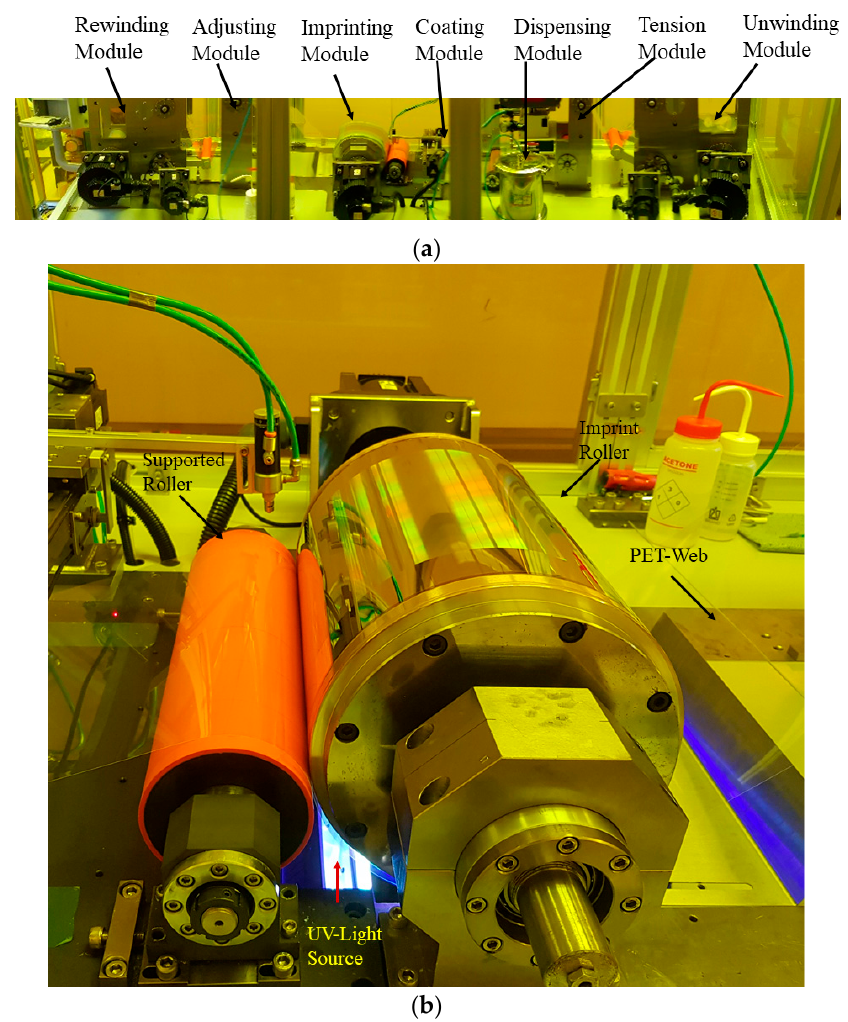
Figure 4. ( a ) R2R-UV experimental setup with drop-casting dispensing unit; ( b ) magnified view of imprinting module with UV light underneath the imprint rollers.